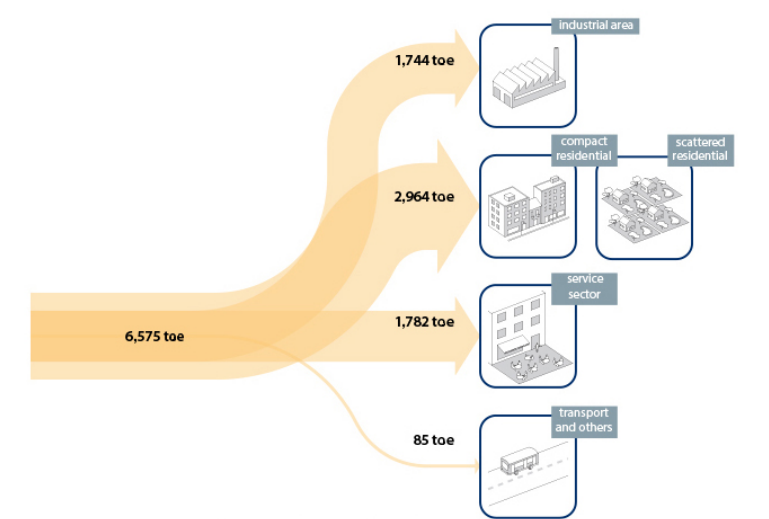
Figure 6. Main electricity flows in the SCSP. Source: Galan